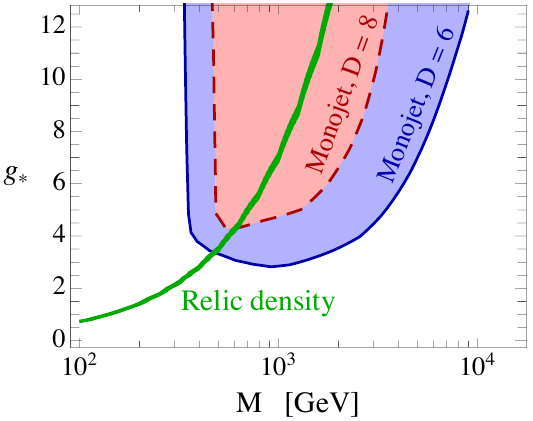
= 5 GeV. Blue region: excluded by consistent Figure 1: Constraints on scalar DM with m DM LHC constraints on D = 6 operator c V in Eq. (4) (e.g. pseudo-NGB DM from a non-abelian SSB ψ pattern), and comparison with the parameters where the RD is correctly reproduced with the same D = 6 operator (solid green). Red region: LHC constraints on D = 8, C T in Eq. (5) (e.g. ψ one scalar DM from an abelian